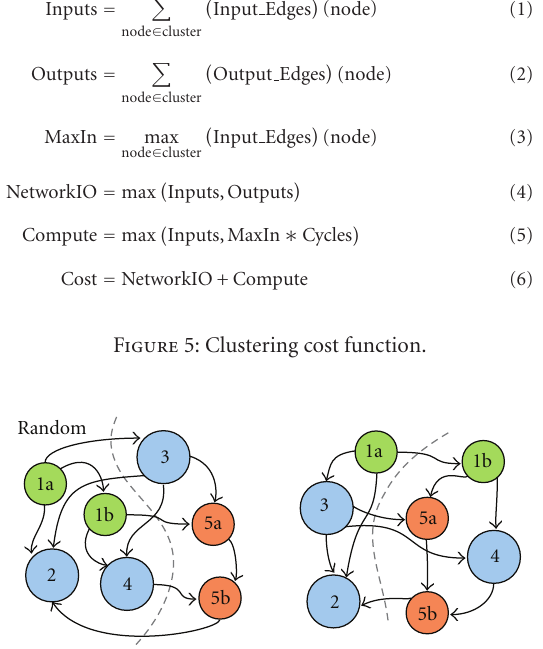
Figure 6: Placement (random placement versus good